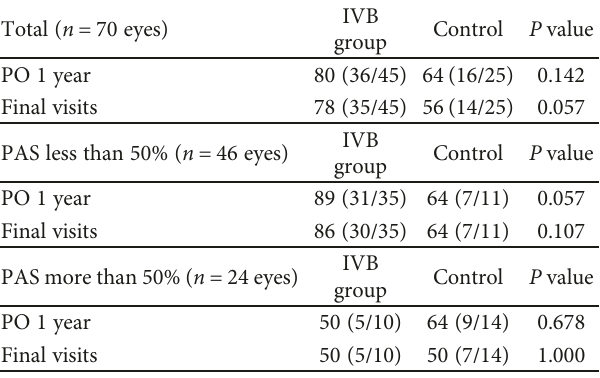
Table 3: Success rates (%) after Ahmed glaucoma valve implantation in the 2 groups for total participants and subgroups according to extent of peripheral anterior